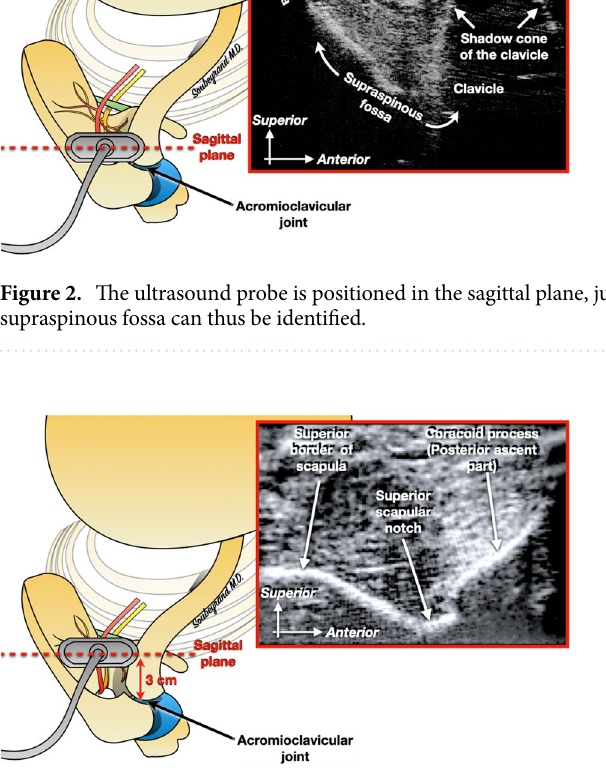
Figure 3. Then the probe is shifted about 3 cm medially to the acromioclavicular joint. This makes it possible to locate the superior scapular notch.